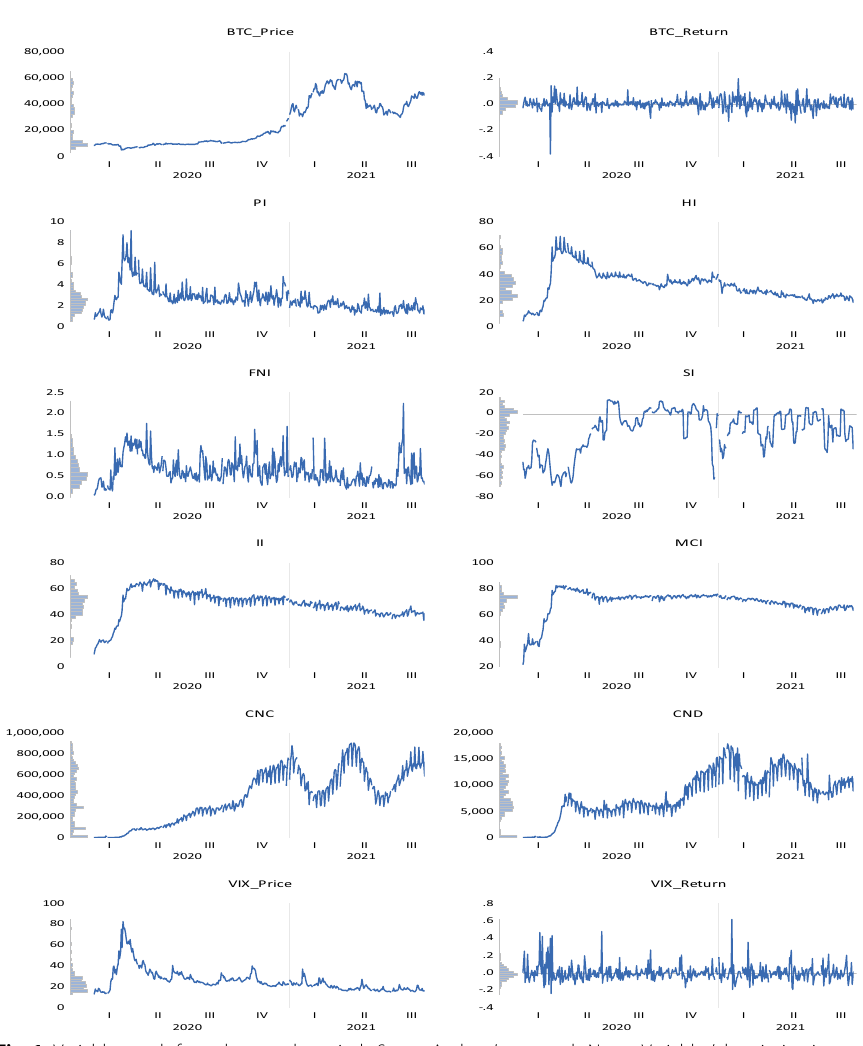
Fig. 1 Variable trends from the sample period. Source Authors’ own work. Notes: Variables’ description is provided in Table